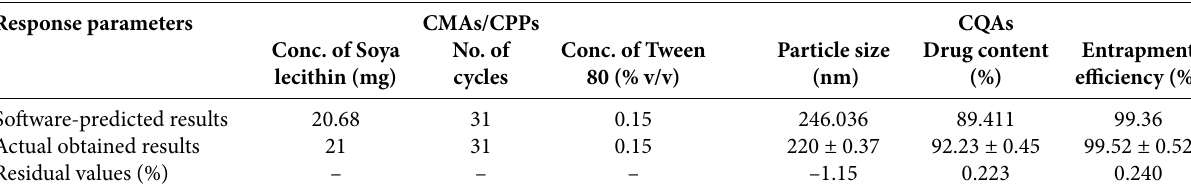
Table 9. Residual values of CQAs of optimized formulations. Response